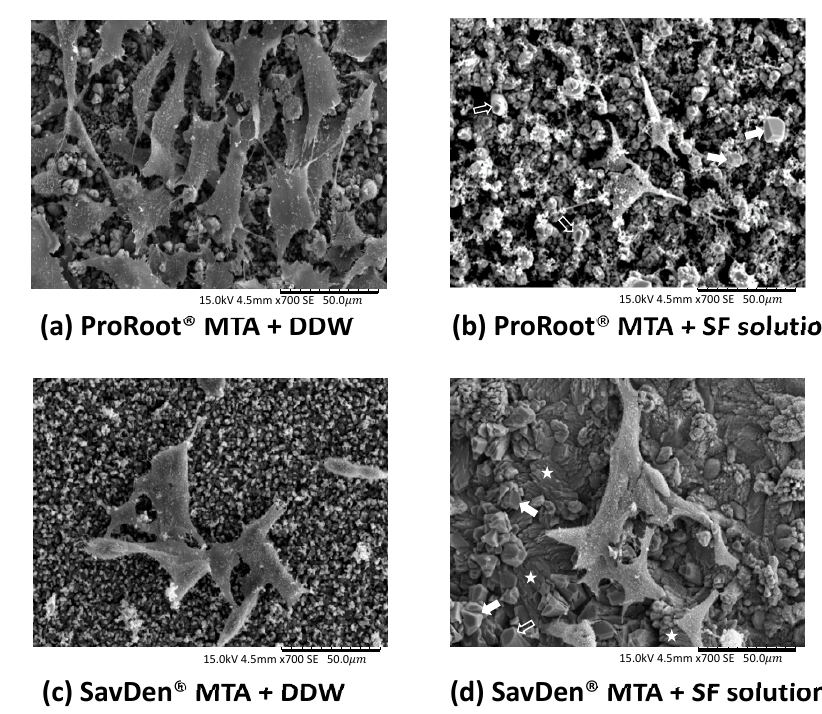
Figure 4. The SEM micrographs demonstrated the morphological features and attachment of MG-63 osteoblast-like cells on surfaces of various set MTAs after hydration for one day and seeded for five days in 37 ◦ C (original magnification, × 700). ( a ) ProRoot ® MTA + DDW and ( c ) SavDen ® MTA + DDW are micrographs of MG-63 cells attaching to cement surfaces set by DDW. In ( b ) ProRoot ® MTA + SF solution and ( d ) SavDen ® MTA + SF solution, two types of hexagonal crystals were marked with arrow. Pillar-like structures were marked with hollow arrow. Hexagonal crystals with planar-like structures and pillar-like structures were marked with arrow and hollow arrow, respectively; while acicular sheet-like crystals were marked with